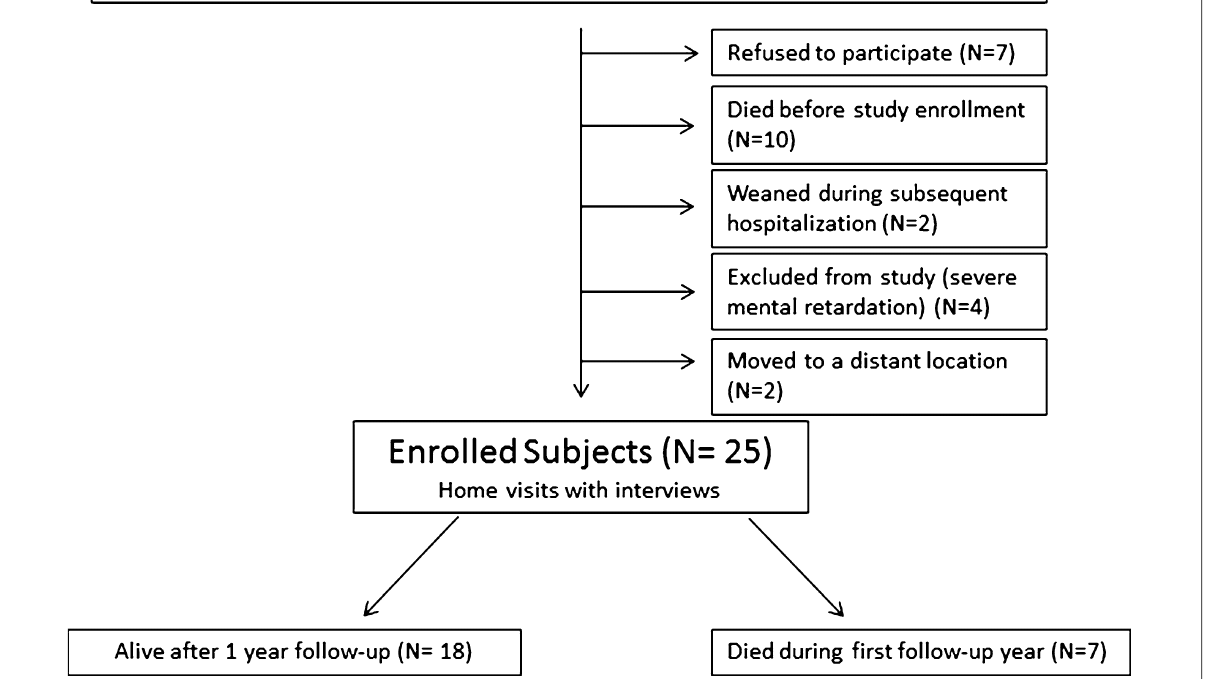
Fig. 1 Flow chart of the study. NIV noninvasive